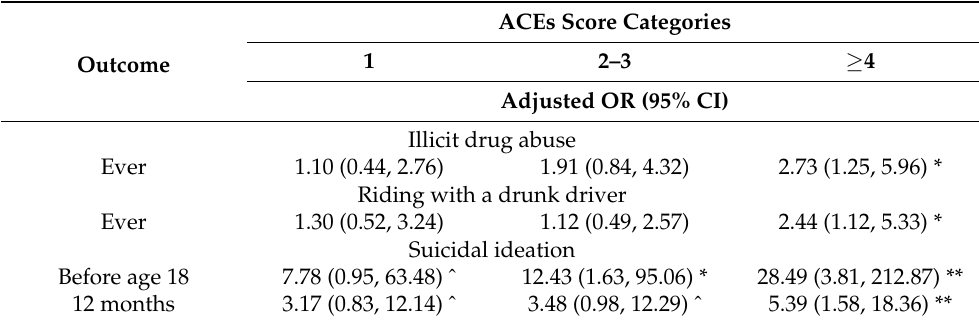
Table 3. Multivariable logistic regression model’s estimation of the association between health risk behaviours and ACE score